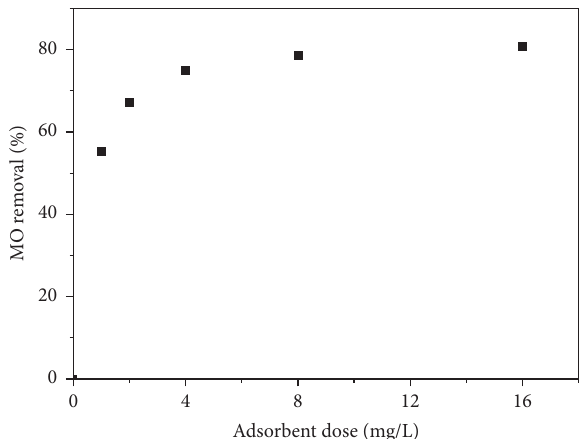
Figure 6: Effect of adsorbent dose on the adsorption of MO ( t